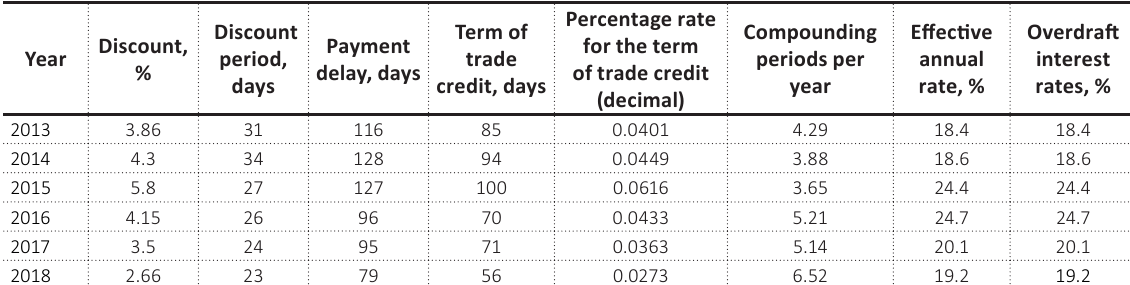
Table 8. The effective annual rate calculation (in case of the overdraft)